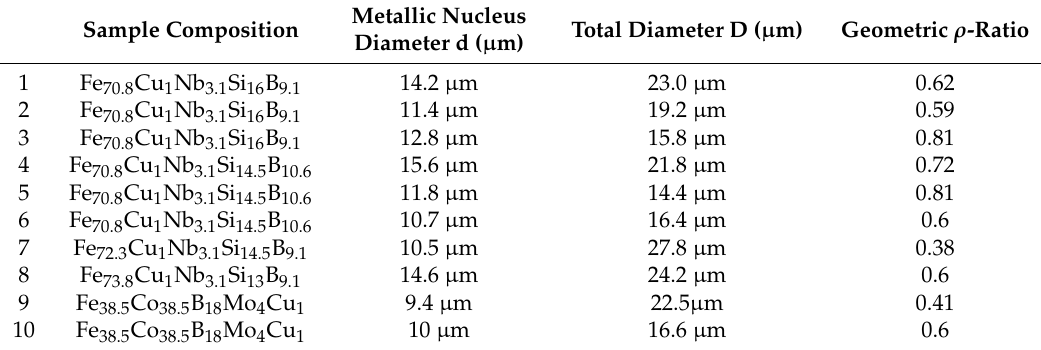
Table 2. Composition and diameter of the metallic nucleus, total diameter and geometric ratio of nanocrystalline glass-coated microwires.